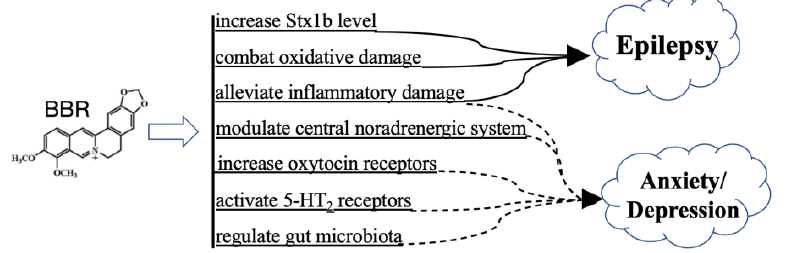
Figure 4. Effects of BBR against psychiatric disorders and epilepsy.